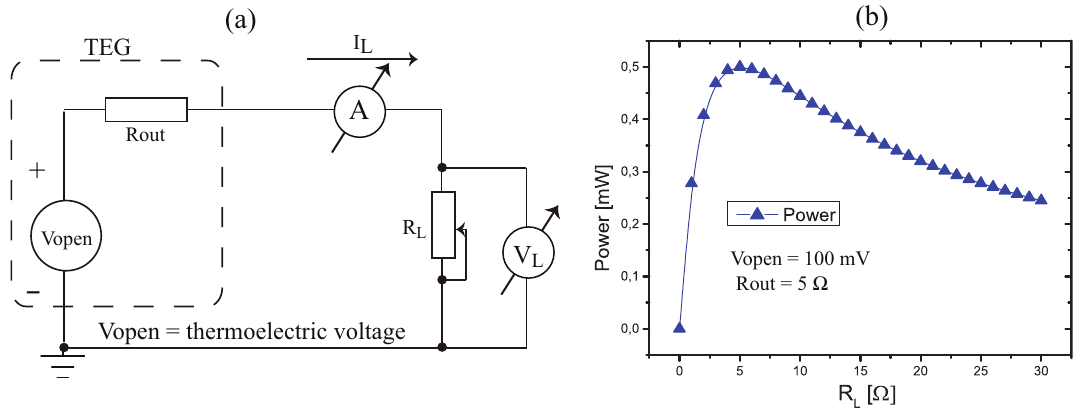
Figure 1. ( a ) scheme for measuring the power of a TEG; ( b ) plot of output power as a function of the external load R L , for V open = 100 mV, R out = 5 Ω